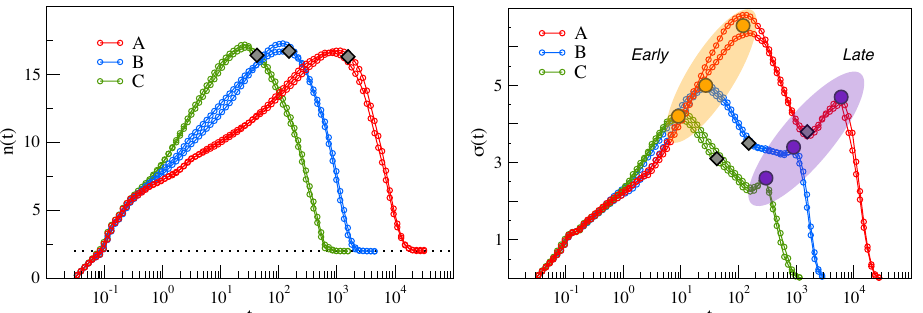
Figure 4. Time-dependence of ¯ n ( t ) , the average number of particles that are MI-correlated with a generic one ( left ), and σ ( t ) , the standard deviation ( right ) for all of the investigated states. Diamonds mark the position of τ α . The two peaks of the standard deviation, also reported in atomic liquids [18], identify two time scales that are referred to as τ early (orange dot) and τ late (violet dot). The data were taken from Reference